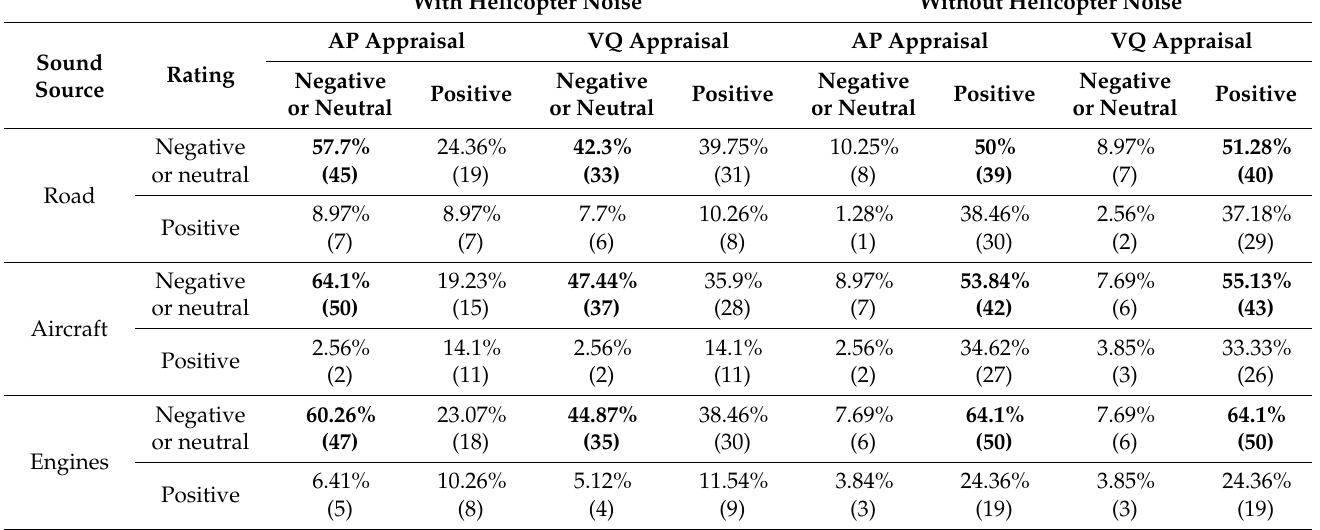
Table A2. Participants’ responses to the pleasantness of the sound sources, split by the number of non-positive (negative or neutral) and positive ratings of the appropriateness of the soundscape (AP) and by the number of non-positive (negative or neutral) and positive ratings of the landscape quality (VQ), with and without the helicopter noise. As there are 3 locations, the total number of responses is the number of participants multiplied by three for both the scenarios with and without helicopter noise. The number of responses is given in parentheses. The highest percentages of participants are marked in bold. In addition, 100% refers to the total number of